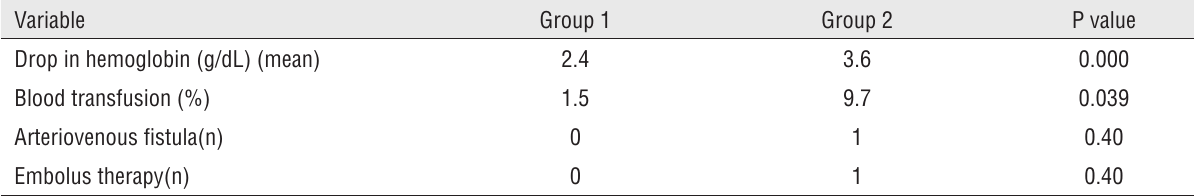
Table 3 - Bleeding